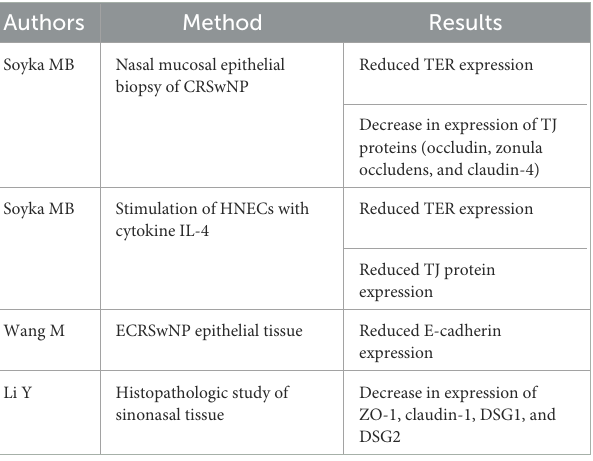
TABLE 1 Studies describing the destruction of CRS epithelial integrity.